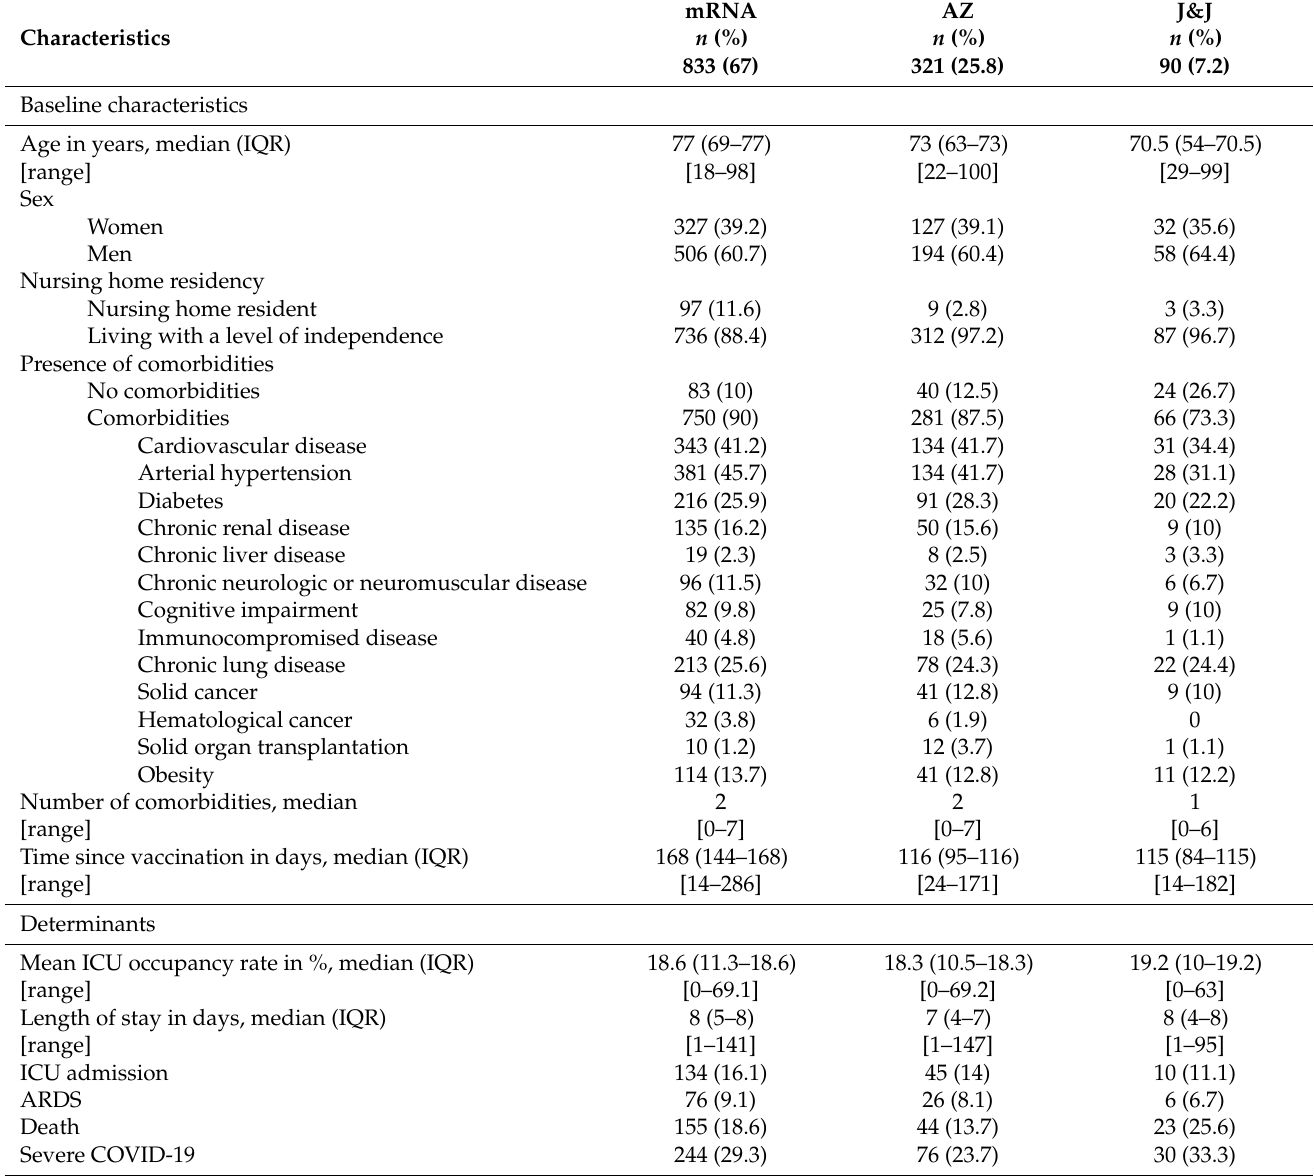
Table 2. Description Delta breakthrough cases subcohort (complete